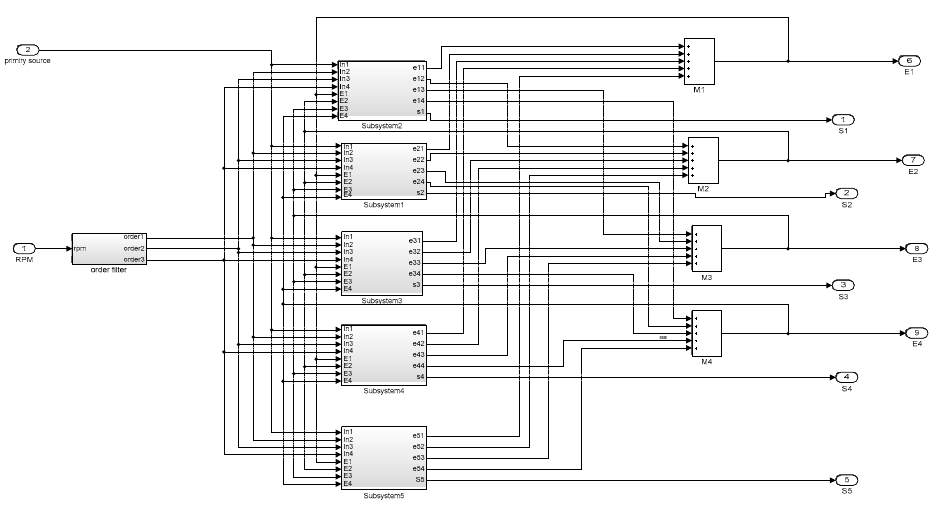
Figure 15. Multichannel ANC algorithm with 5 subsystems used for this test based on Simulink.